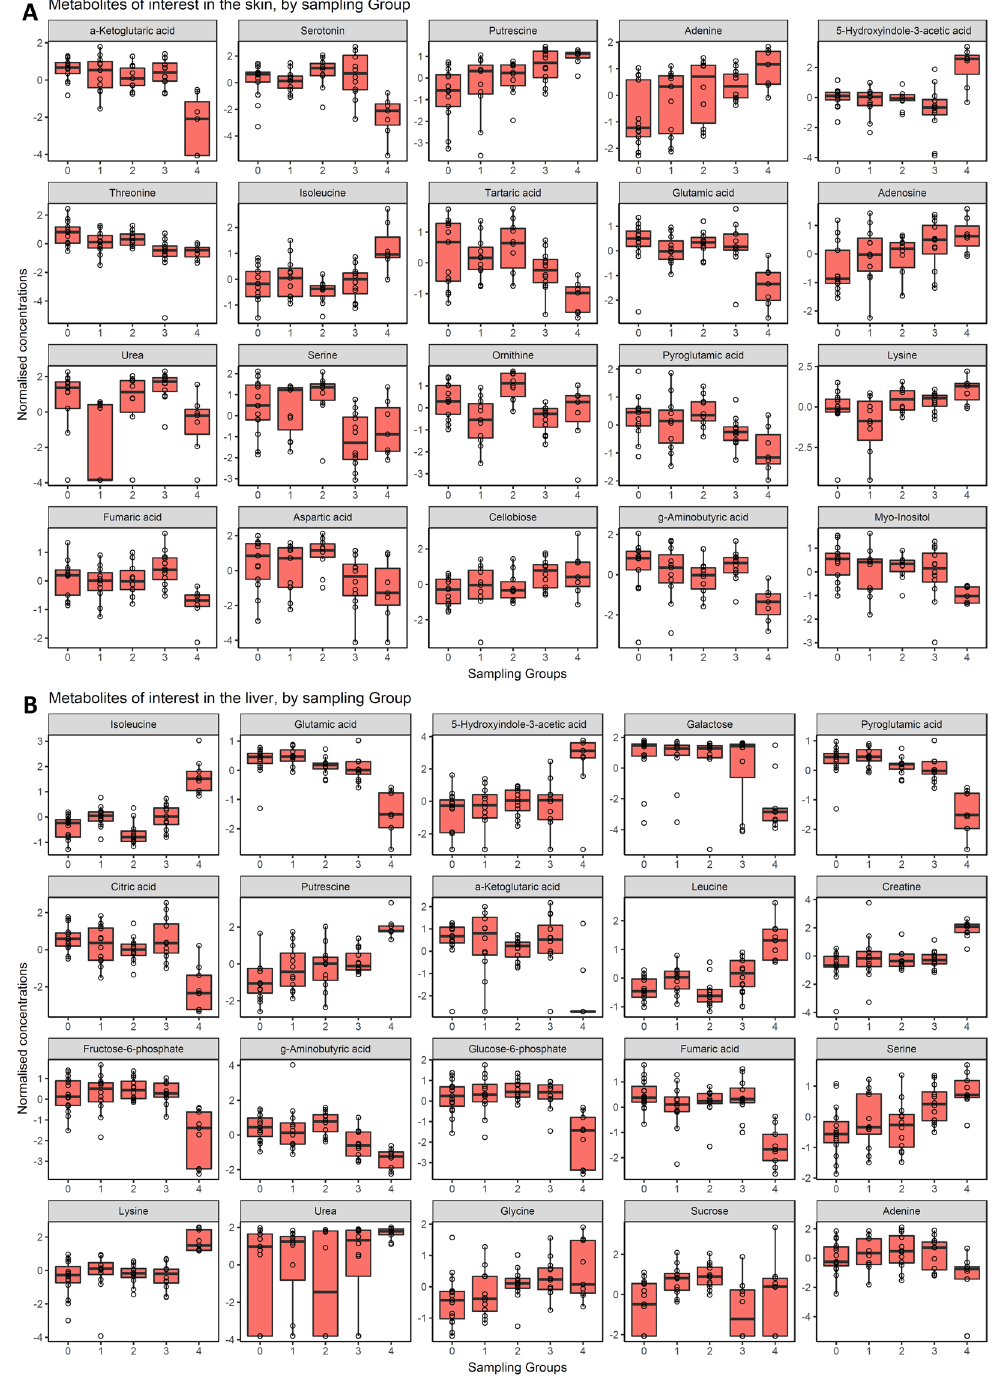
Figure 1. Box and whisker plots (with data points overlaid) of the relative concentration of identified metabolites of interest according to their sampling group (using geom_boxplot from ggplot2 R package). ( A ) Metabolites from skin samples, ( B ) metabolites from liver samples. Sham-exposed negative control group frogs were designated Group 0. Exposed/infected frogs sampled at various times post-exposure were designated Groups 1, 2, 3 and 4, corresponding to being sampled at 4, 8, 14 and 28–30 days post exposure, respectively. Box hinges represent first and third quartiles, and middle represents the median. Whiskers extend 1.5 times the inter-quartile range of the hinge. Boxes are ordered by relative metabolite